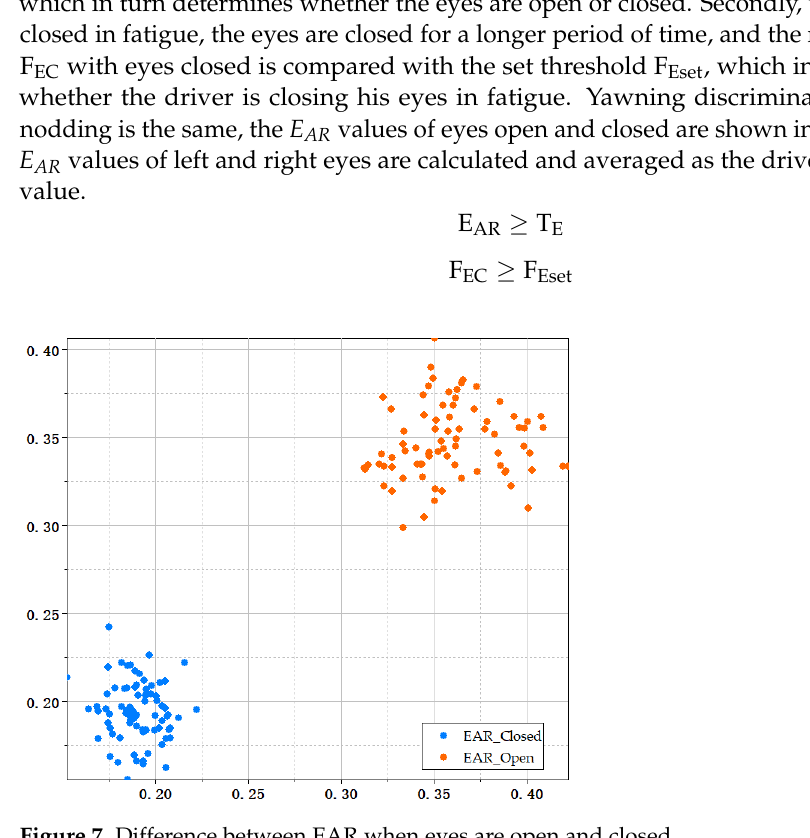
Figure 6. Magnitude of pitch variation in different cases.